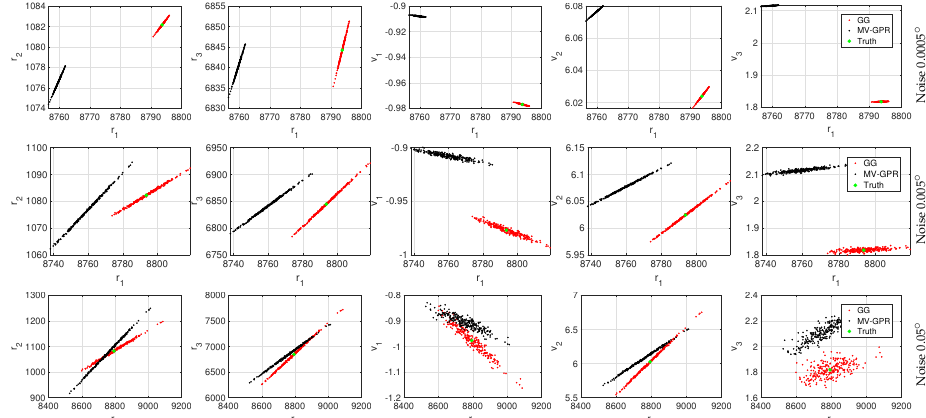
Figure 14. Qualitative study of Orbit A at various noise levels. The black points are MV-GPR and the red are Gauss–Gibbs predictions,while the green point represents the truth.